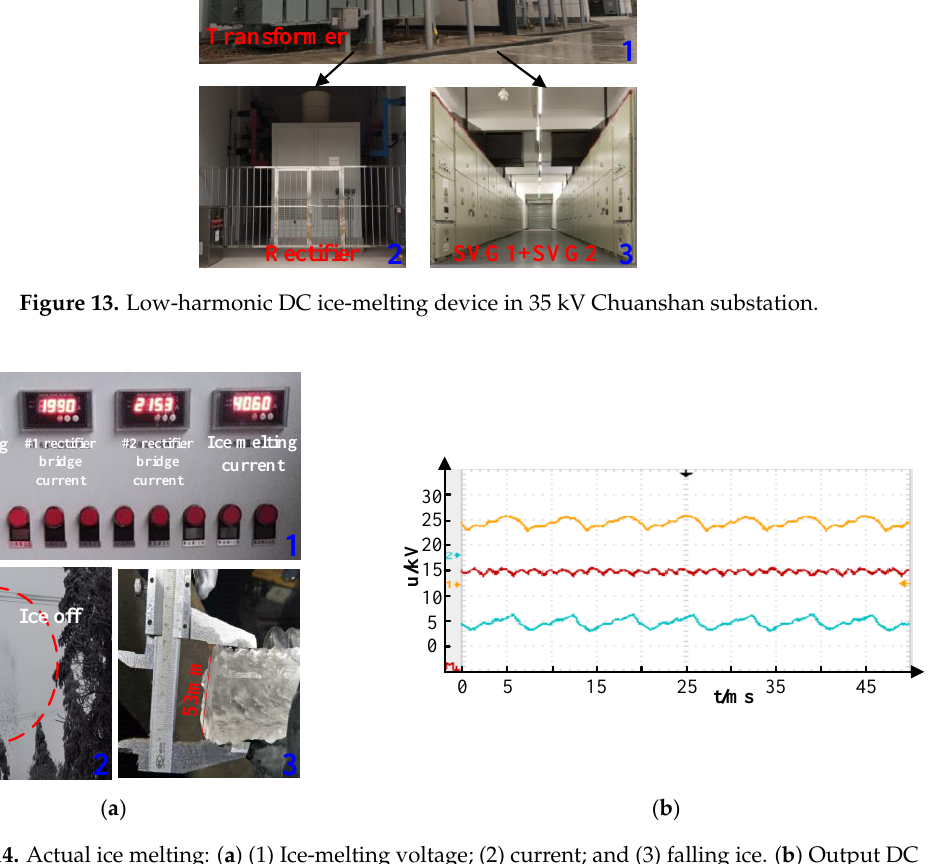
Figure 14. Actual ice melting: ( a ) (1) Ice-melting voltage; (2) current; and (3) falling ice. ( b ) Output DC voltage waveform.